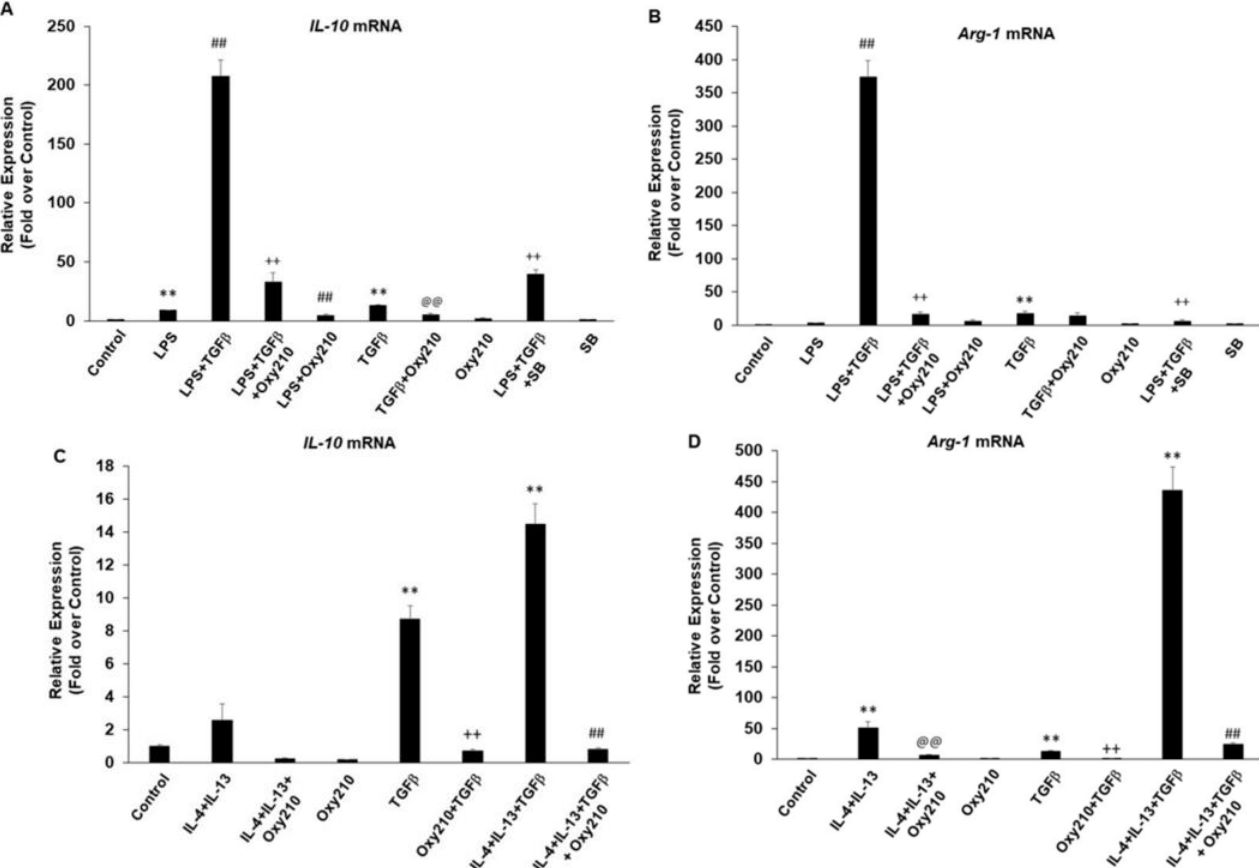
Figure 15. Inhibition of LPS, TGF- β , and IL-4+IL-13 induced M2 polarization of RAW264.7 macrophages by Oxy210. Cells were pretreated with Oxy210 (5 µ M) or SB431542 (5 µ M) in